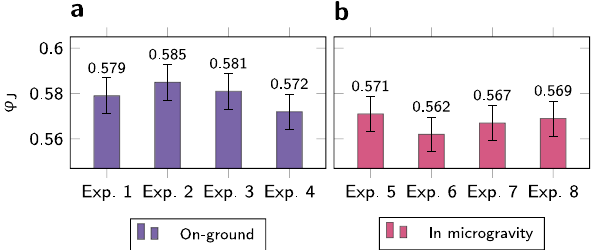
Fig. 3 Packing fraction at jamming φ J , estimated from the height at which the piston is driven to a halt by the resistance of the packing. Experiments are conducted in the same setup, a on- ground (gnd) and b in microgravity ( μ -g). Error bars represent the formal accuracy (see Methods section for details on the